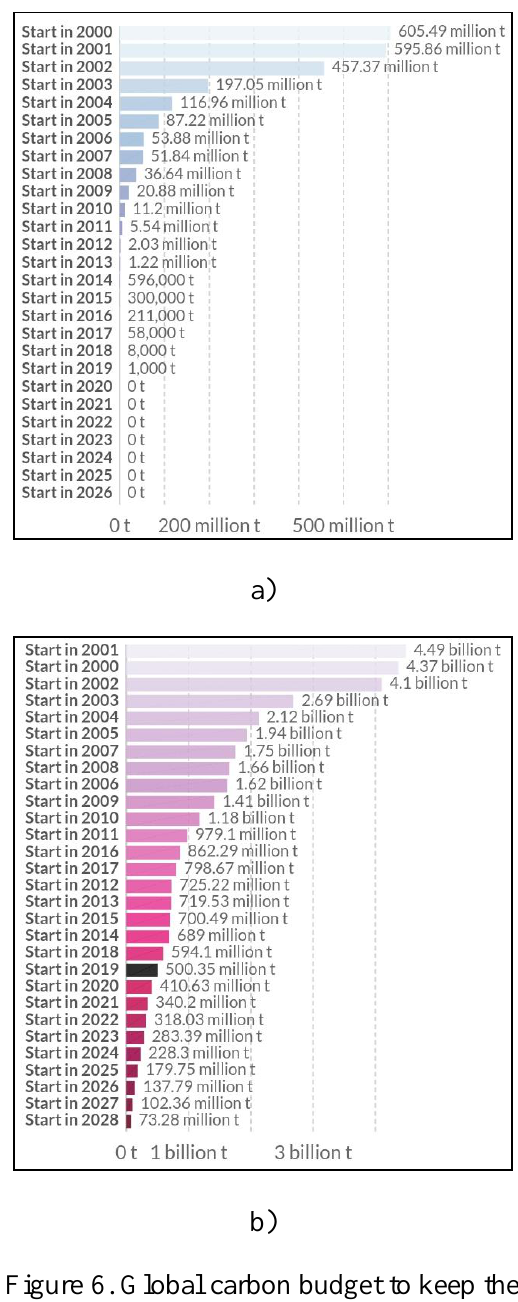
Figure 6. Global carbon budget to keep the temperature rise below 1.5 °C and 2 °C: a) CO reductions needed to keep global 2 temperature rise below 1.5 °C (Note: Carbon staying below 1.5 °C, b) CO 2